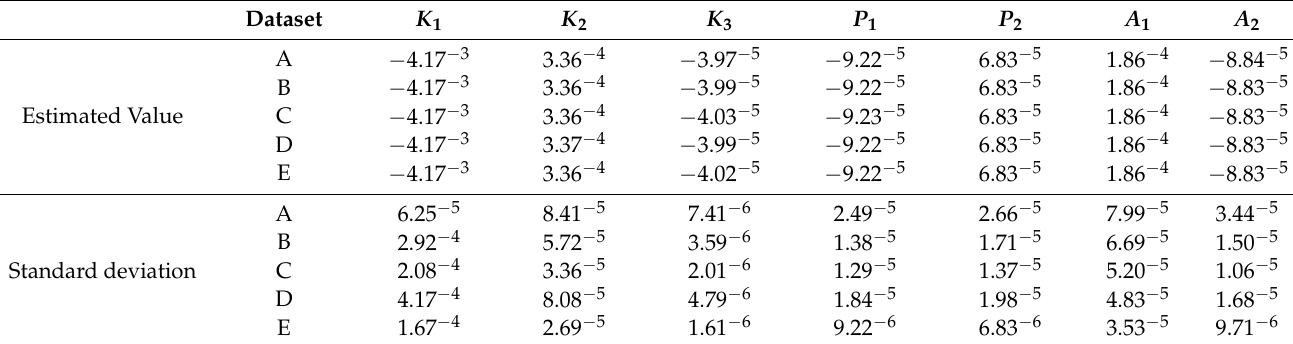
Table 13. Estimated values and standard deviations of lens distortion parameters in real experiments (camera 2).